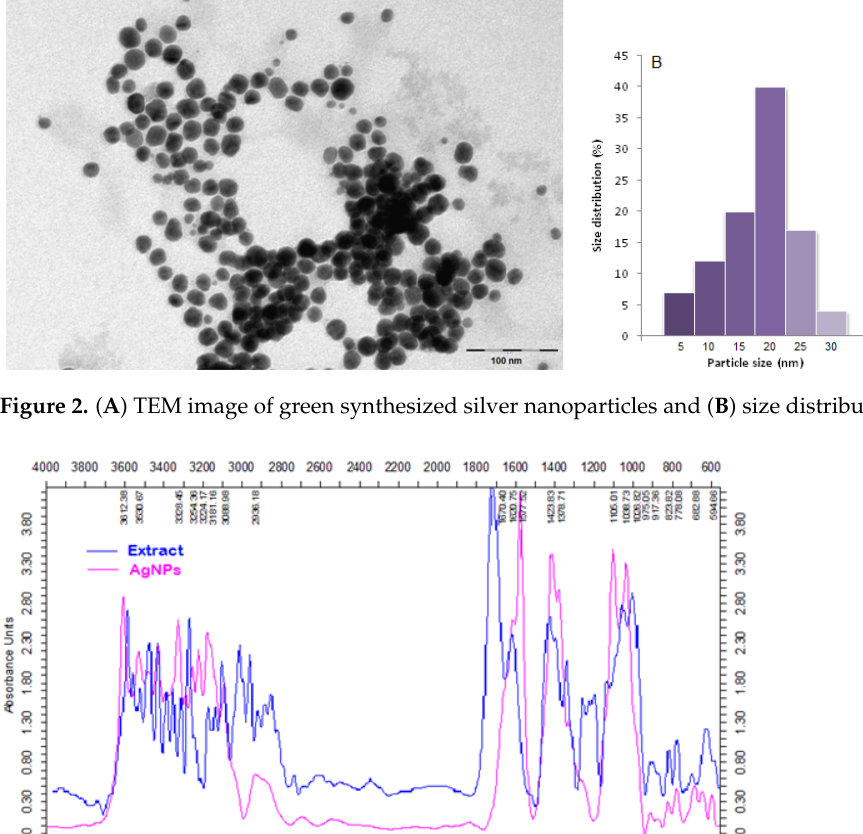
Figure 2. ( A ) TEM image of green synthesized silver nanoparticles and ( B ) size distribution.